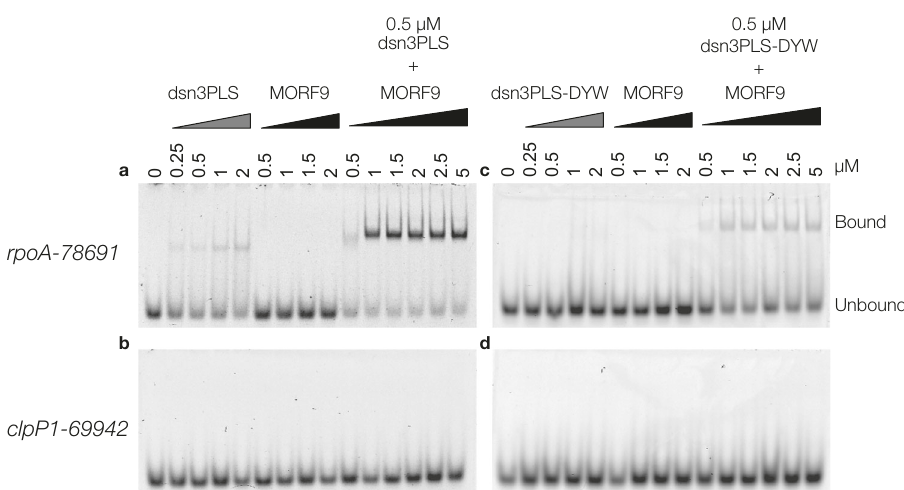
Fig. 2 MORF-enhanced sequence-speci fi c binding of Dsn3PLS proteins to rpoA-789691 target RNA. Binding assays were performed with dsn3PLS ( a , b ) or dsn3PLS-DYW ( c , d ) in comparison to, or together with, MORF9 in the presence of 1 nM rpoA-78691 target RNA ( a , c ) or clpP1-69942 ( b , d